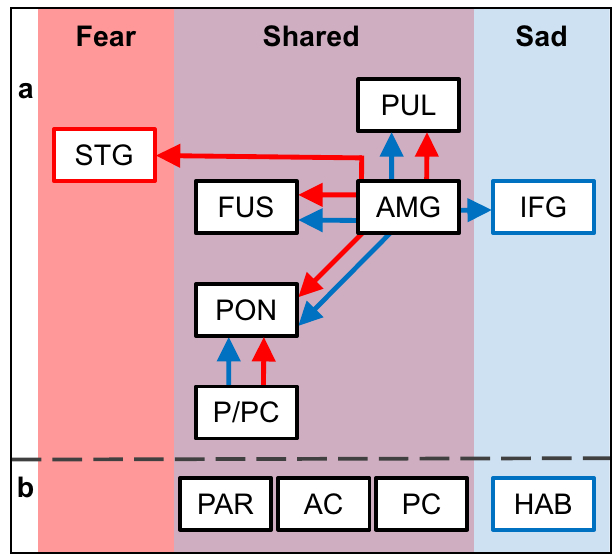
Fig. 5 Unique and shared networks for processing fearful and sad affective information. Proposed network and regions involved in processing fear and sad affective information. a Network of connections identi fi ed via GCM analysis. Arrows indicate the dominant direction of in fl uence. Red = pathways for processing fear; blue = pathways for processing sadness. b ROIs not identi fi ed as part of the connected network in GCM analysis, but signi fi cantly involved in processing affective information as revealed by GLM and MVPA. AC anterior cingulate cortex, AMG amygdala, FUS fusiform, HAB habenula, IFG inferior frontal gyrus, PAR parietal, PC posterior cingulate cortex, PON pons, PUL pulvinar, P/PC